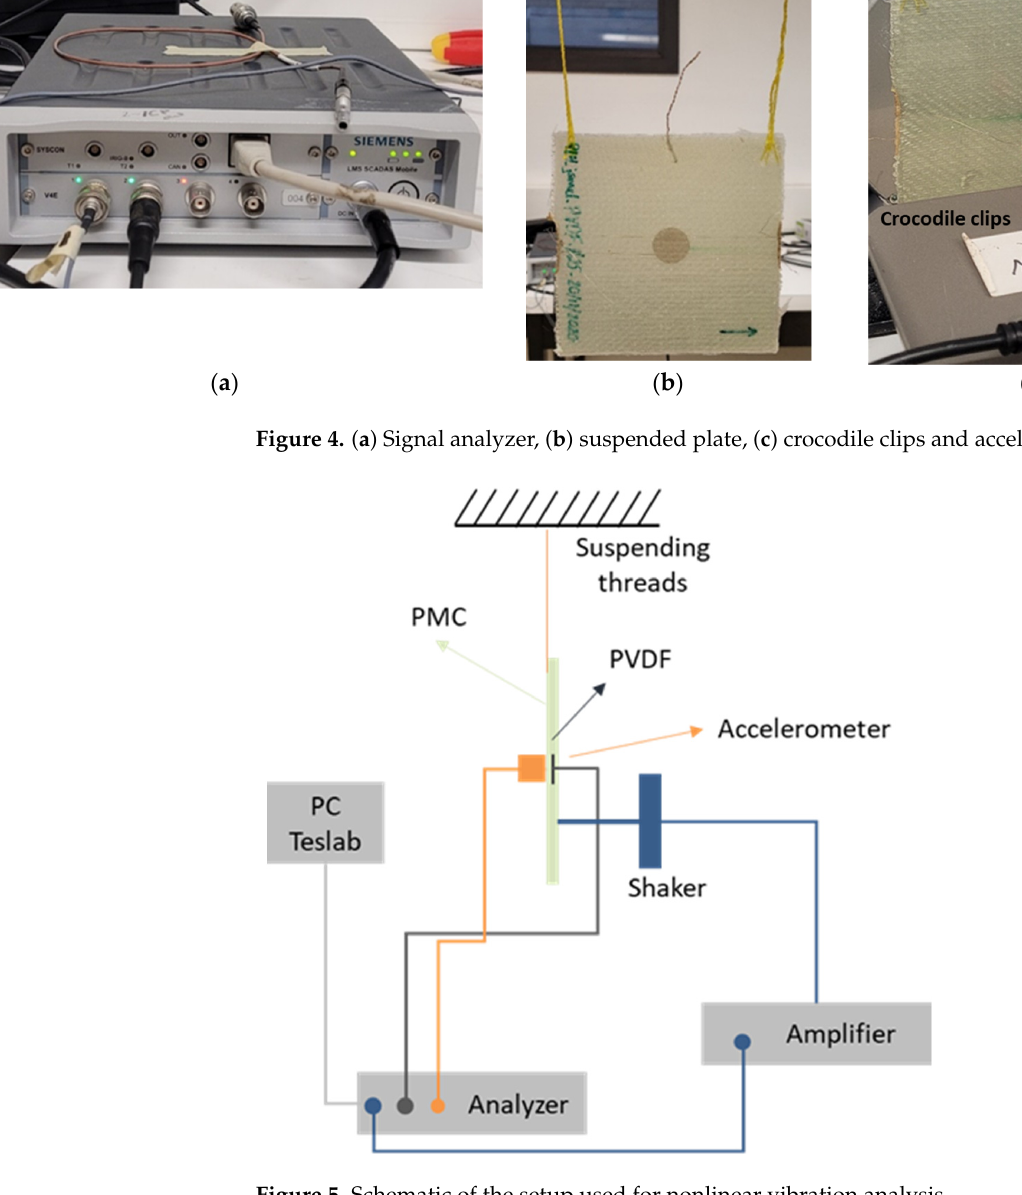
Figure 5. Schematic of the setup used for nonlinear vibration analysis.